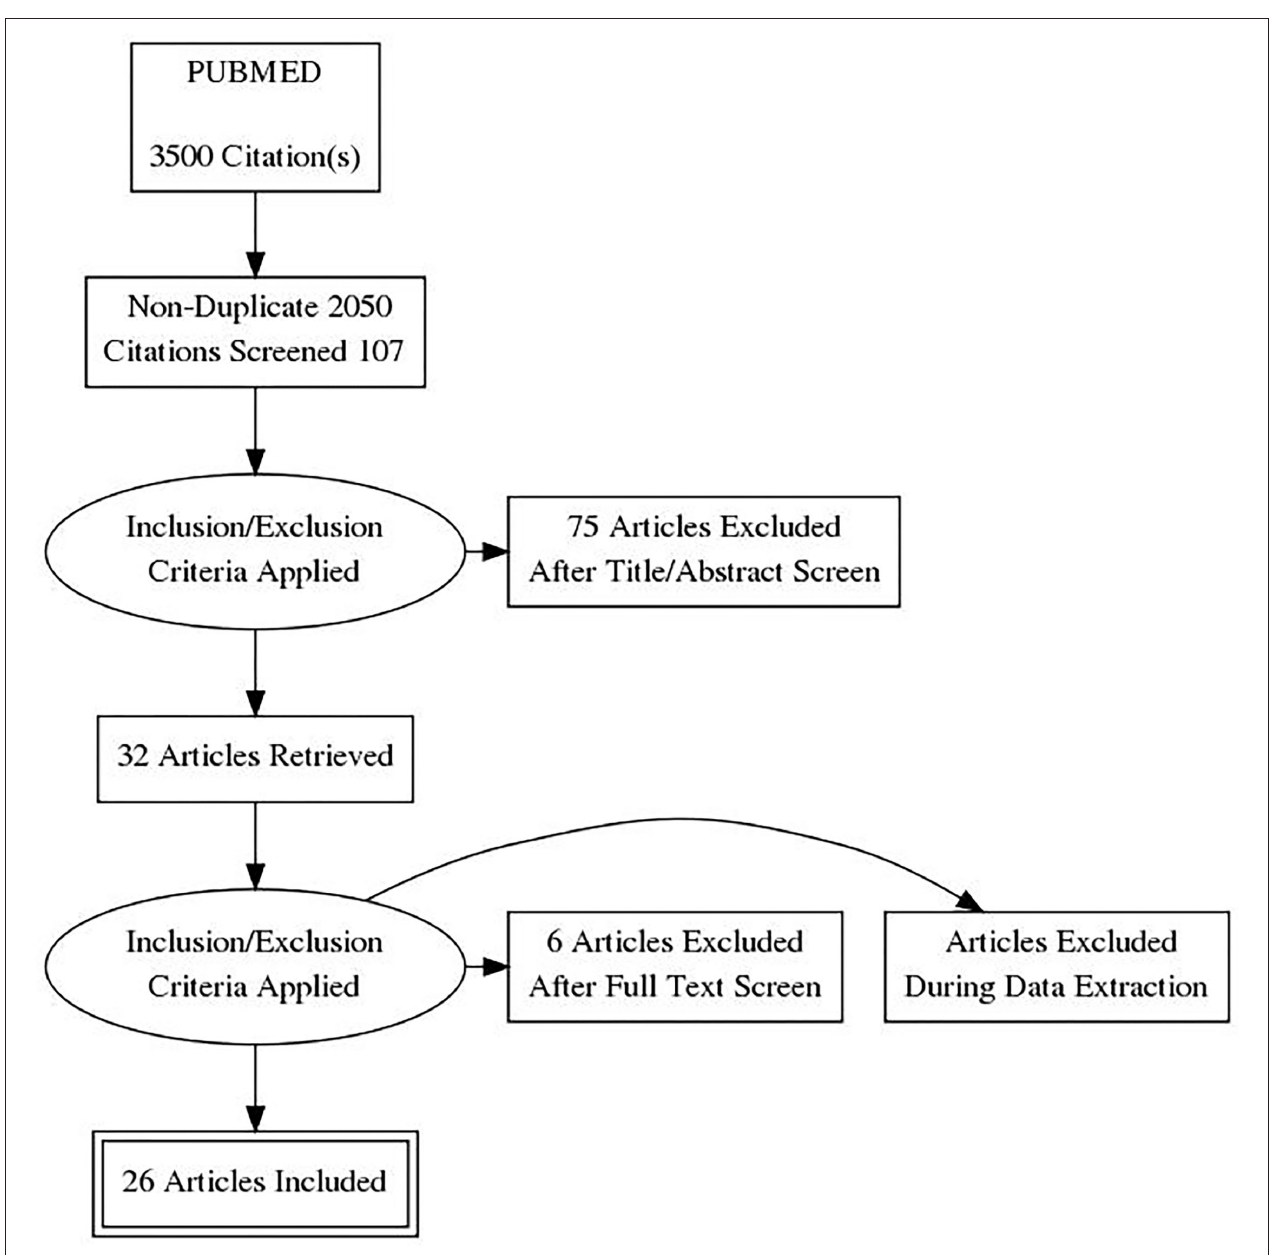
FIGURE 1 | PRISMA flow